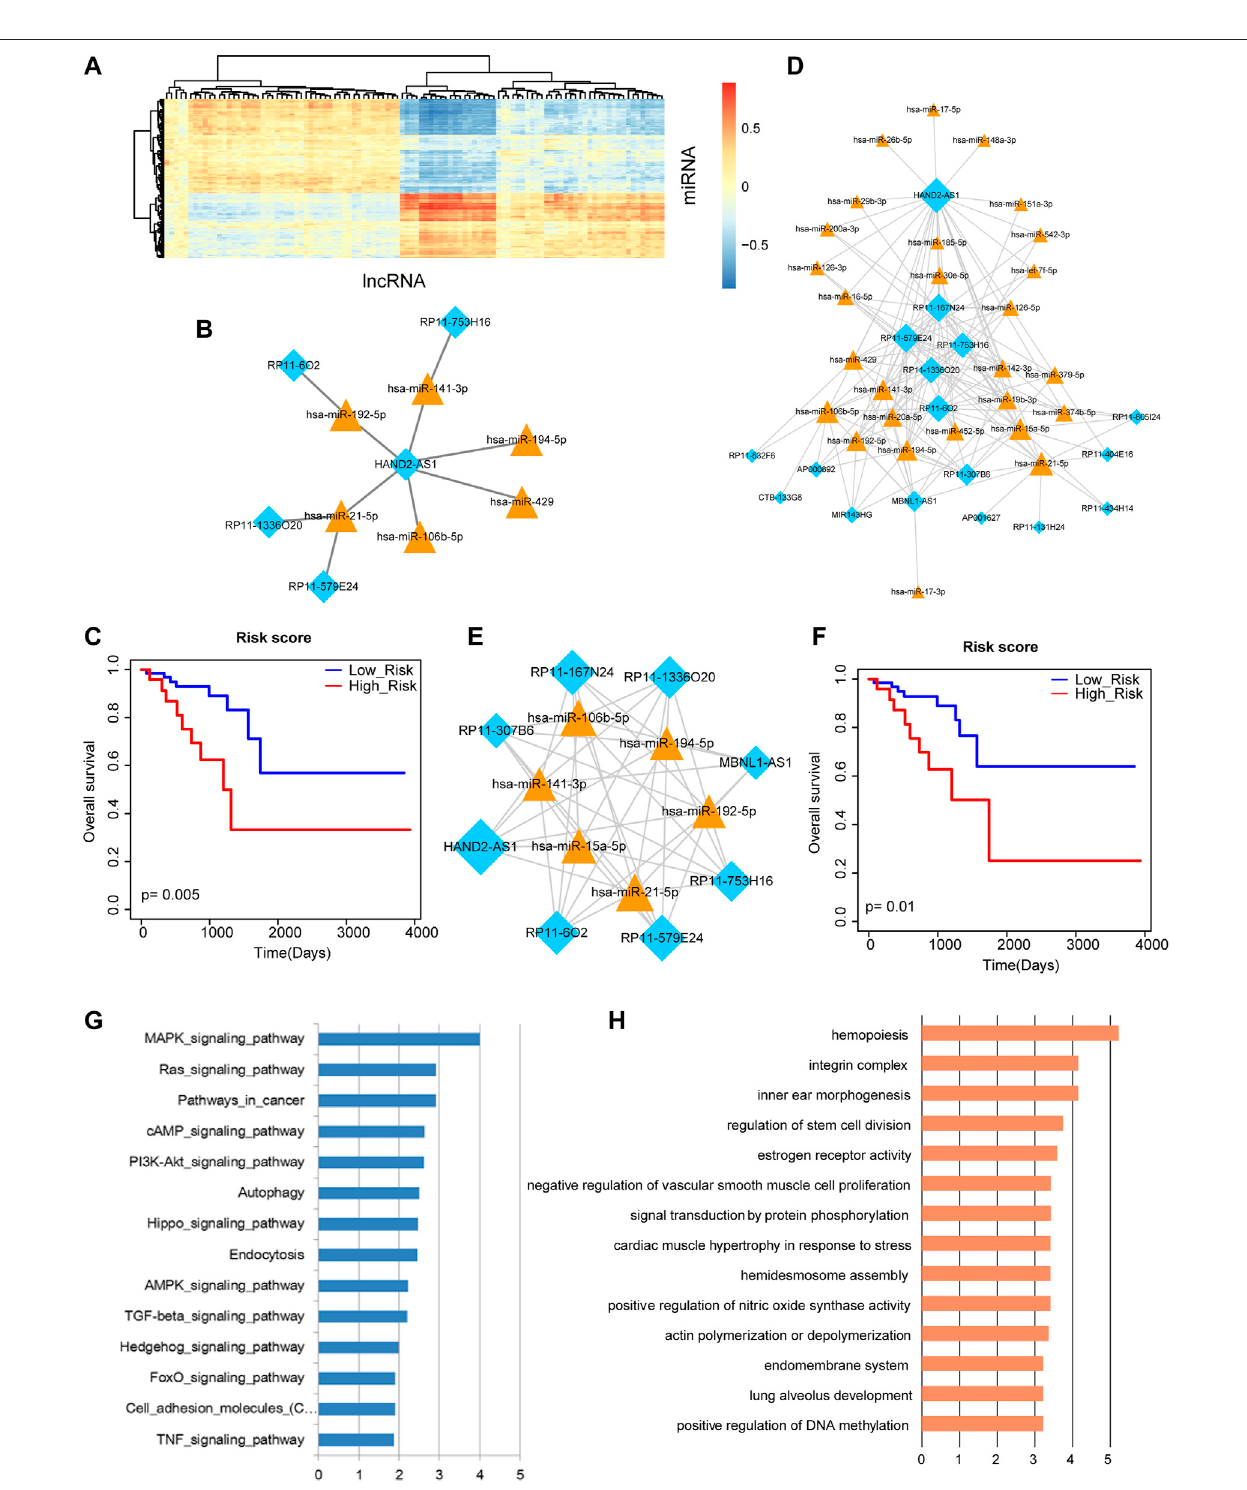
FIGURE 3 | Analysis of miRNA-lncRNA network and its nodes. (A) The heat map of correlations between DE miRNAs and DE lncRNAs. (B) The most negatively expression-correlated 10 DE miRNA-DE lncRNA interaction pairs. (C) A Kaplan-Meier survival curve of the six miRNAs and fi ve lncRNAs that express negatively correlated ( p = 0.005). (D) The rectal cancer-related miRNA-lncRNA network. Yellow triangle represents miRNA and blue diamond represents lncRNA. Node size represents degree of node. (E) The top 20% miRNA and lncRNA hub nodes with the largest degrees in the miRNA-lncRNA network. (F) A Kaplan-Meier survival curve of these hub miRNAs and lncRNAs ( p = 0.01). (G) Pathway enrichment analysis of these hub miRNAs. (H) GO Term enrichment analysis of these hub miRNAs.